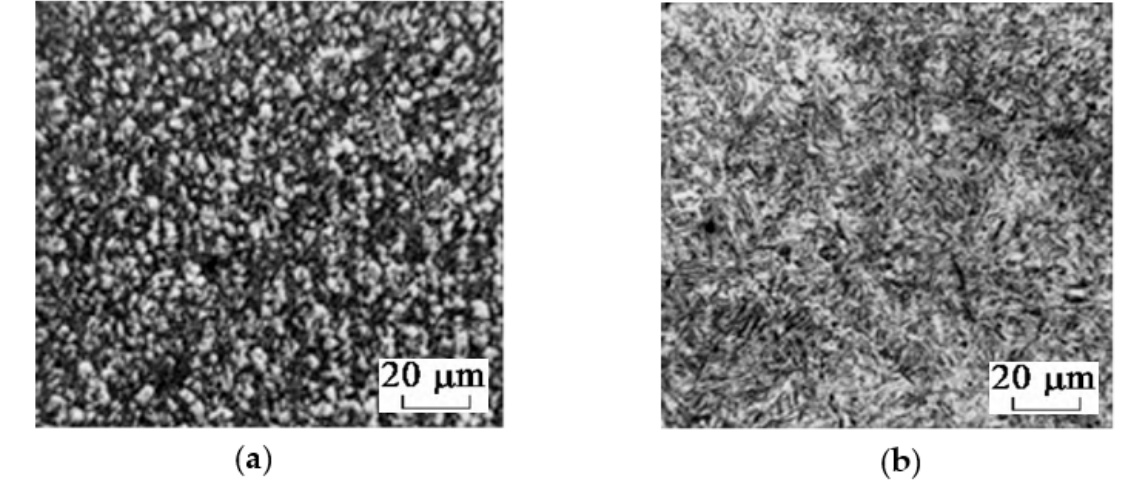
Figure 17. Microstructure of B-pillar: ( a ) Slow cooling zone; ( b ) Rapid cooling zone.